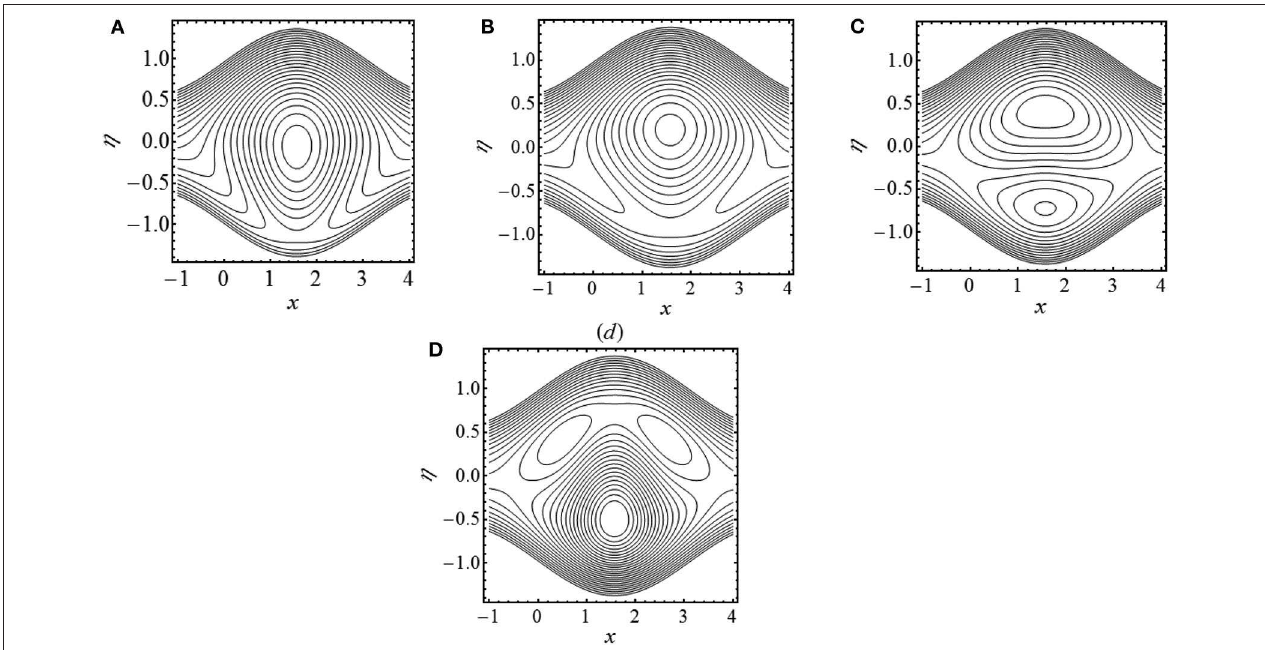
FIGURE 10 | Streamlines in wave frame for (A) N 1 = 0.8, (B) N 1 = 1, (C) N 1 = 1.2, and (D) N 1 = 1.4. The other parameters chosen are Ha = 2, N 2 = 1.2, γ = 2.5, and λ =